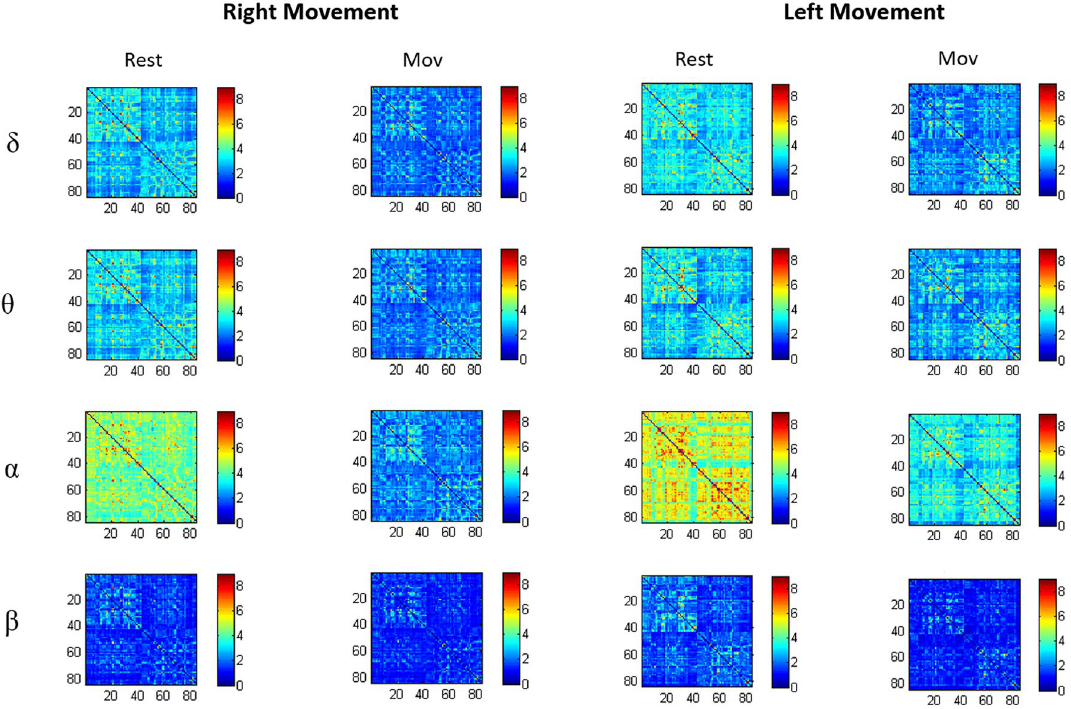
Figure 2. Connectivity matrices in Rest and Mov conditions averaged across subjects in δ, θ, α, β frequency bands. Each matrix element provides the color-coded LLC value between Brodmann areas as indicated by the colour bar. The upper left quadrant of the matrices depicts LLC among Brodmann’areas of the left hemisphere and the lower right quadrant shows LLC among areas of the right hemisphere (the figure was obtained with Matlab R2018 https:// it. mathw orks. com/ produ cts.